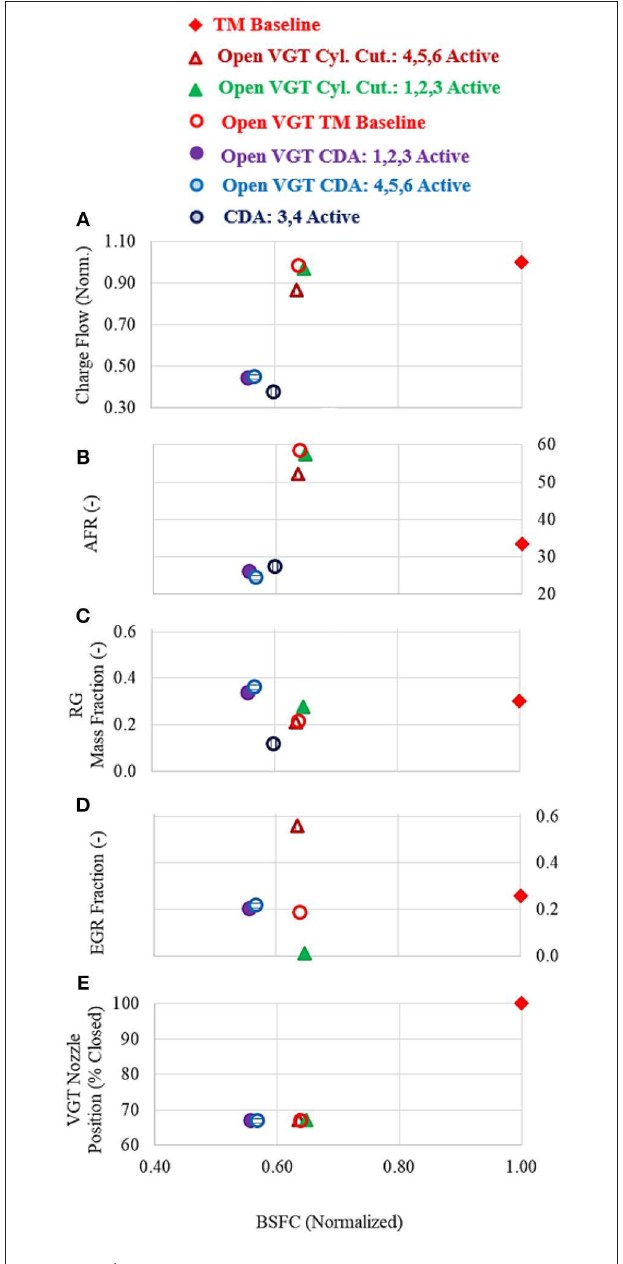
FIGURE 12 | (A) Charge flow through the engine normalized to the TM Baseline . (B) Air-to-Fuel ratio for each of the experimental cases. (C) Recirculated gas mass fraction, corresponding to Equation (4). (D) EGR fraction, corresponding to Equation (5). (E) VGT position, in which 100 % is an over-closed